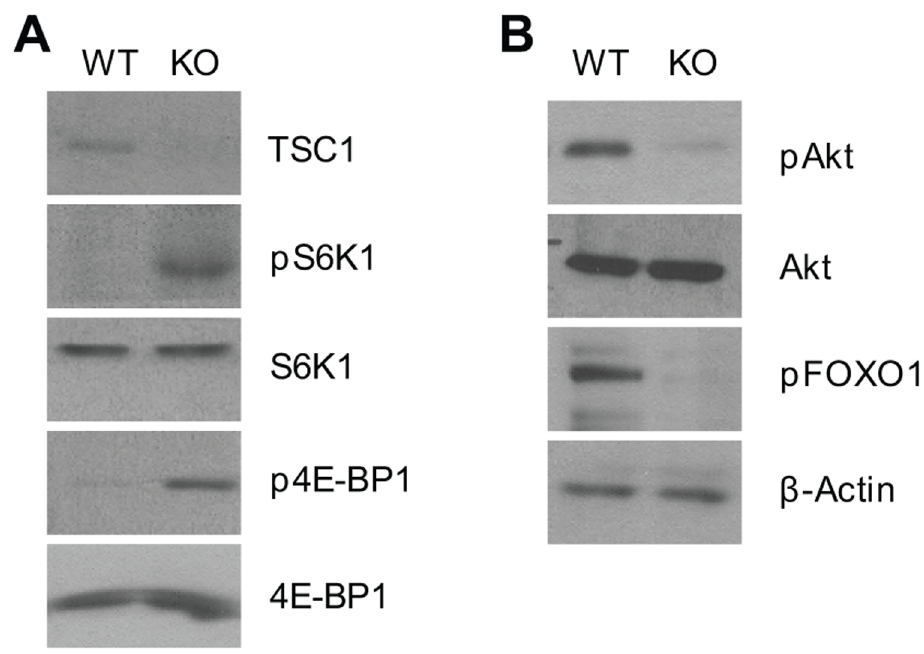
Fig 4. Differential effects of TSC1 deficiency on mTORC1 and mTORC2 signaling in B cells. Sorted CD93 - B220 high mature B cells from WT and TSC1KO splenocytes were lyzed in 1%-NP-40 lysis buffer and subjected to immunoblotting analysis with the indicated antibodies. (A) Enhanced mTORC1 signaling in TSC1KO mature B cells. (B) Decreased mTORC2 signaling in TSC1KO mature B cells. Data shown are representative of three